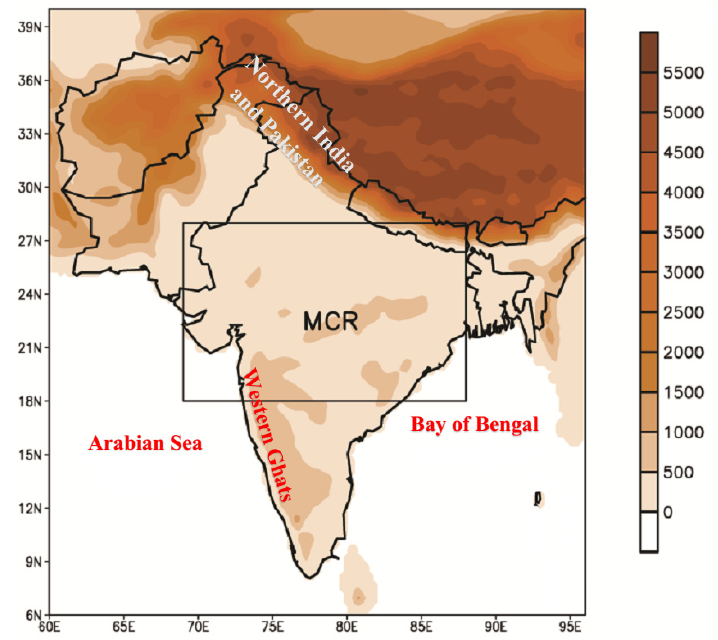
Figure 1. Domain and topography of the RegCM covering South Asia. Surface elevation